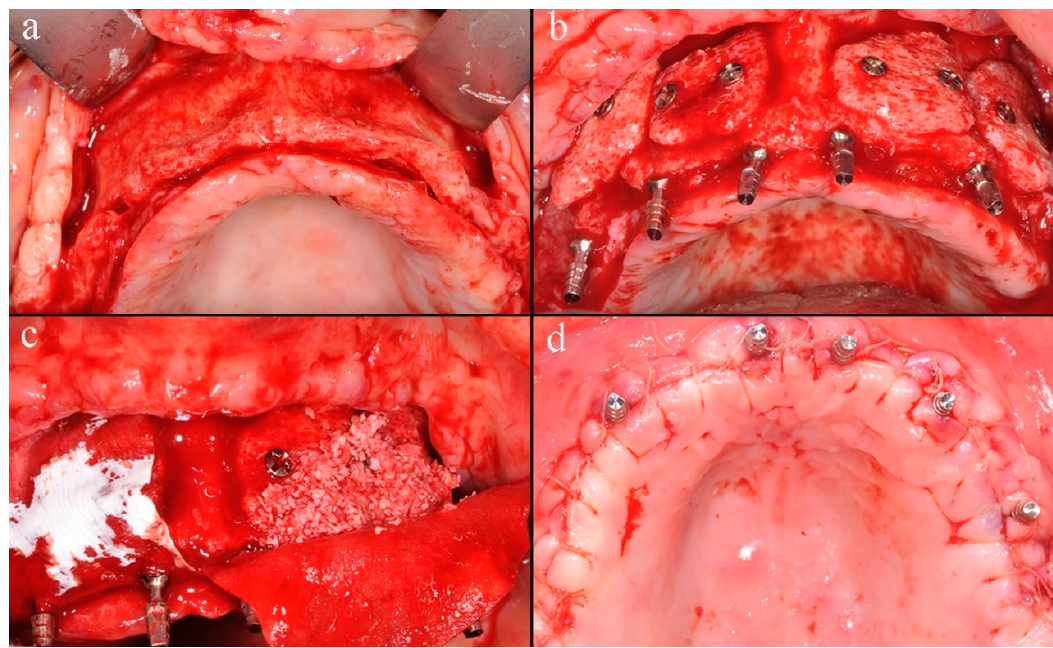
Figure 2. Reconstructive surgery: ( a ) exposition of the maxillary buccal surface after the elevation of the mucoperiosteal trapezoidal flap; ( b ) custom-made blocks fixed into planned positions and six provisional implants insertion; ( c ) grafted blocks and remaining spaces of the recipient site filled with a mix of biomaterial and autogenous bone chips and covered by resorbable membranes; ( d ) suture of the coronally advanced flap.